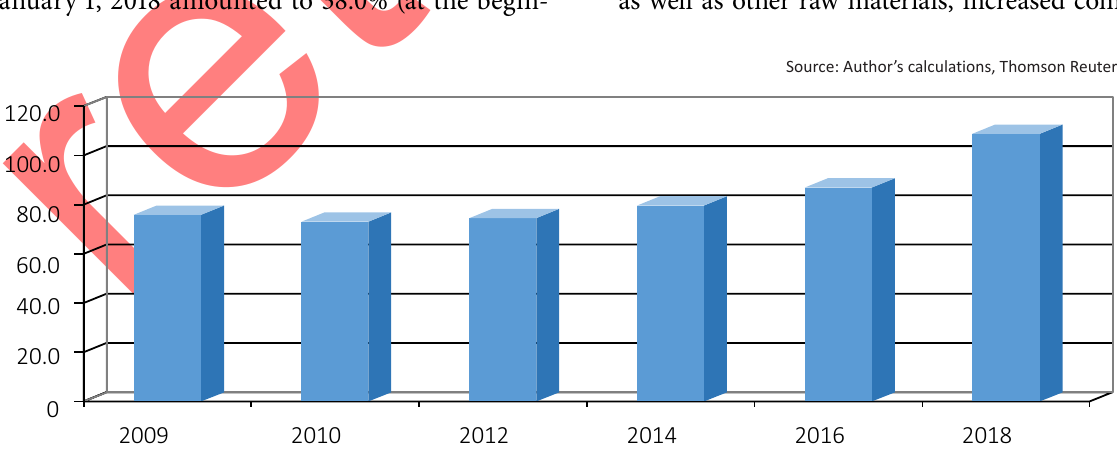
Figure 2. Growth dynamics of total assets (liabilities) of the banking sector, % of